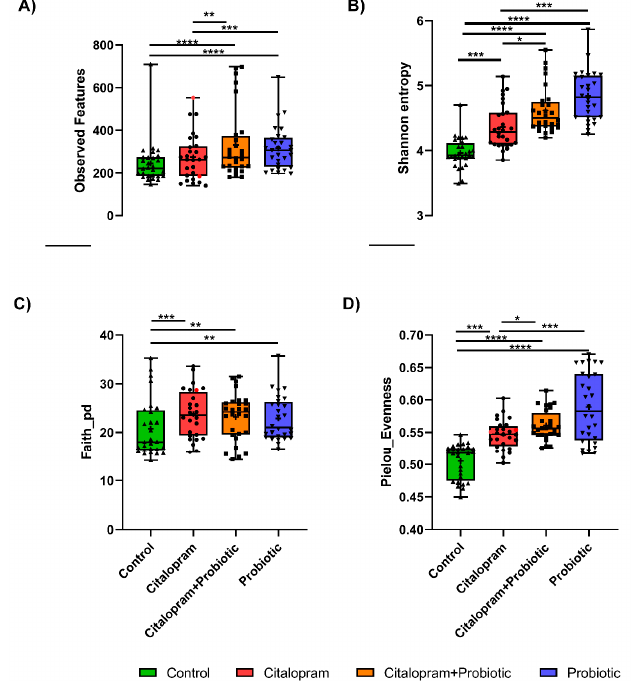
Figure 2. Modulation of microbiota composition following treatment with (S)-citalopram and pro- biotics. ( A ) observed features, ( B ) Shannon index, ( C ) Faith’s phylogenetic diversity, and ( D ) Pielou evenness of all treated samples ( n = four biological replicates each). Results were calculated from rarefied 12,000 reads per sample using QIIME2. 2020.6 version. Middle lines represent the mean. Data were analyzed using the Kruskal- Wallis test and Two-stage Benjamini, Krieger, and Yekutieli FDR procedure; * p < 0.05, ** p < 0.01, *** p < 0.001, **** p < 0.0001. Red dots represent the zero time points.